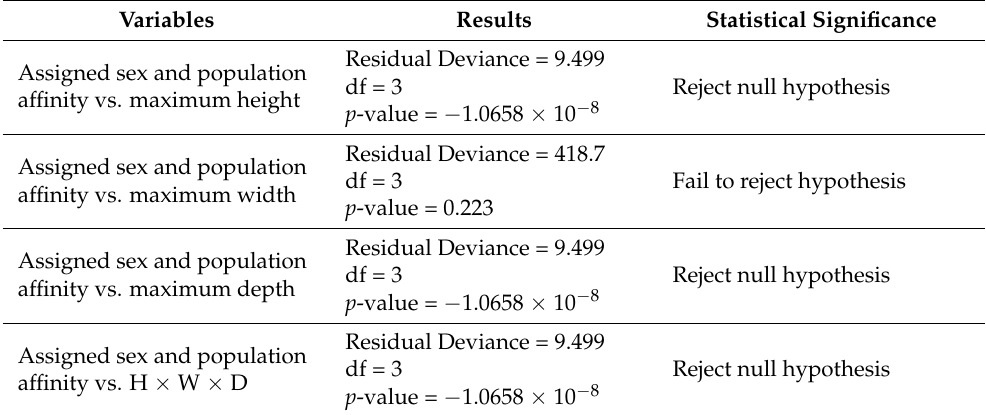
Table 3. ANOVA tests of assigned sex and population affinity vs. the dimensional variables (maxi- mum height, maximum width, maximum depth, and H × W × D).